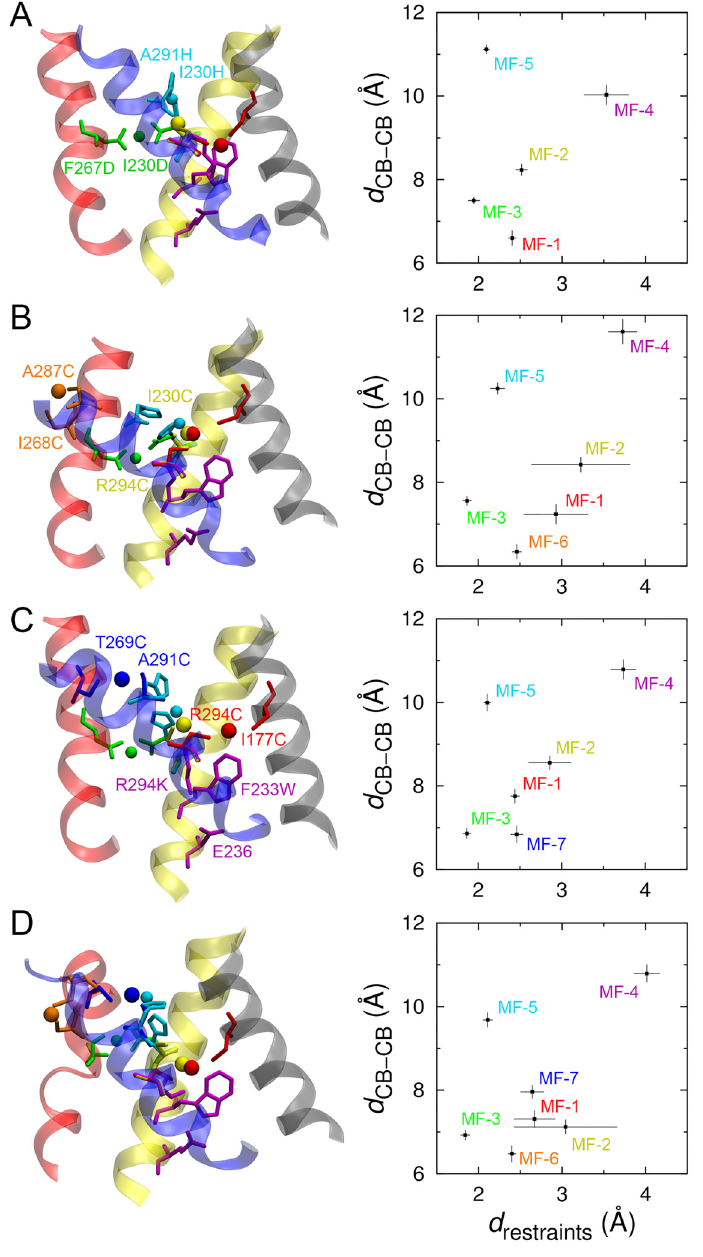
Fig 3. Final configurations of the four models of the VSD with different molecular fragments. The final configuration (left panel) and the correlation between the C β -C β distance and the S γ -Cd 2+ , O δ 2 -Mg 2+ , N ε -Zn 2+ , or N ζ -O ε 2 distance in each molecular fragment (right panel) of (A) model-1, (B) model-2, (C) model-3, and (D) model-4. The last 10 ns trajectories of the restrained MD simulations were used to calculate the average values and standard deviations of the